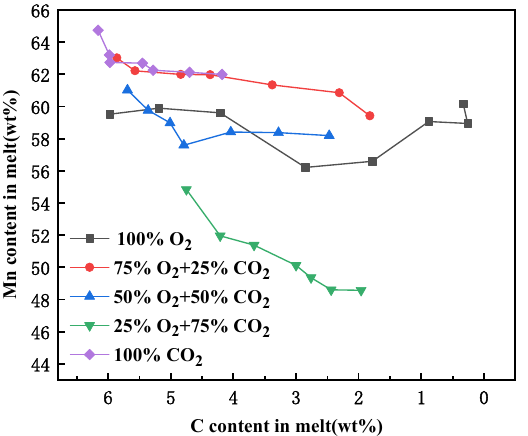
Figure 5. Variation in manganese content with change in carbon content when blowing different CO 2 ‐ O 2 mixtures .